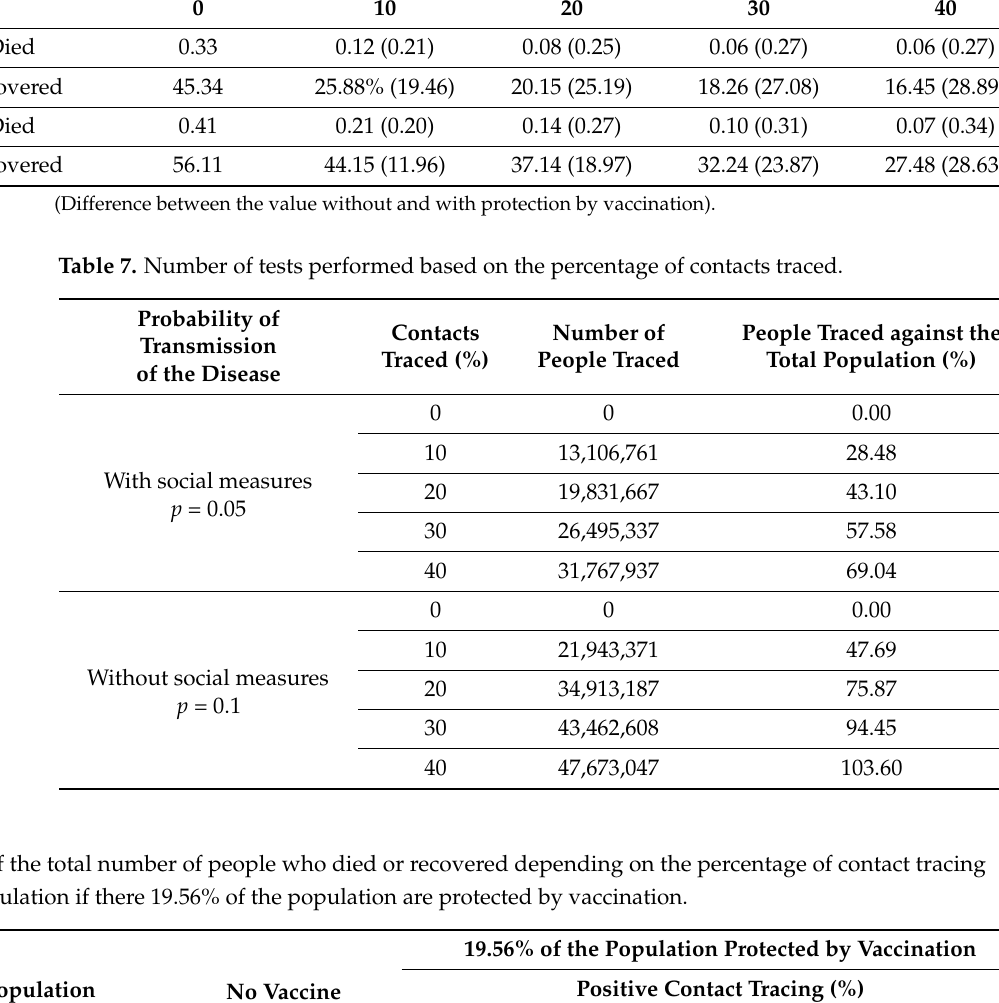
Table 6. Average number of expected people who died or recovered depending on the percentage of contact tracing carried out in the population. Percentages are with respect to population size (46,014,554 people). People with Positive Contacts That Have Been Traced (%) Social Measures